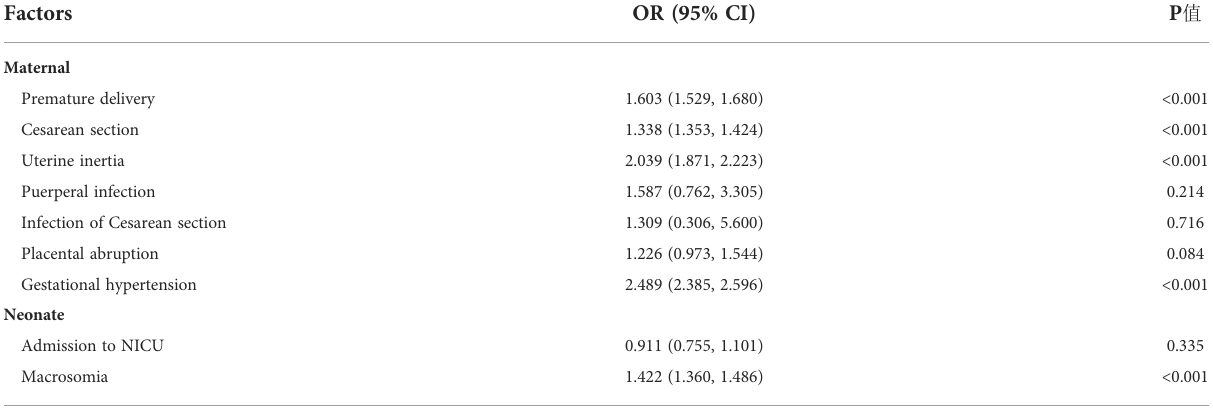
TABLE 3 Univariate logistic regression analysis model of maternal and infant outcomes of GDM individuals.